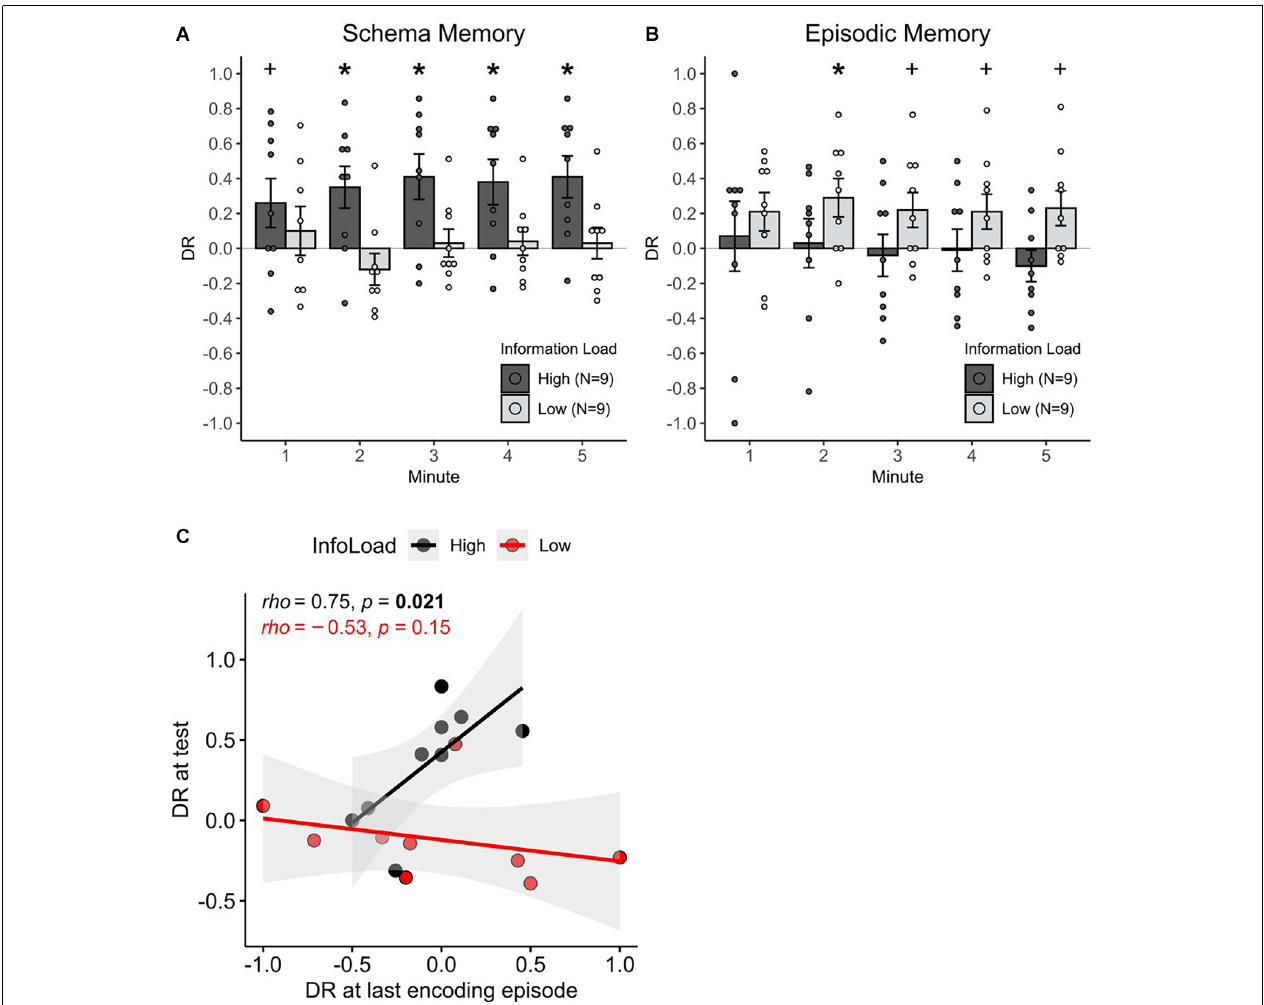
FIGURE 2 | The effect of information load on episodic and schema memory formation. (A) Mean + S.E.M. cumulative discrimination ratios during the 5-min test phase for the schema version of the task ( n = 18), and (B) for the episodic version of the task ( n = 18). Red asterisks indicate significant (above chance) memory per min (* p < 0.05, + p < 0.1). Schema memory for the spatial rule was expressed only in the high, but not in the low information load condition. Episodic memory was transiently expressed only in the low information load condition (2nd min). Significance for the information load (high, low) × memory type (schema, episodic) interaction ( p < 0.001) points to an effect of episodic vs. schema memory in opposite directions. (C) Correlations of the discriminatory exploration towards the partially occupied location (DR > 0) at the last encoding episode in the high and low information load condition of the schema version of the task and the respective memory performance at the test. Ratios are taken from the first 2 min of the encoding and test episodes since memory expression was clearly present in that minute. Correlations significantly differ between the groups ( p < 0.01). Note the significant positive correlation for the high information load condition suggests an emergent schema representation during the last encoding episode is predictive for schema memory recall at the